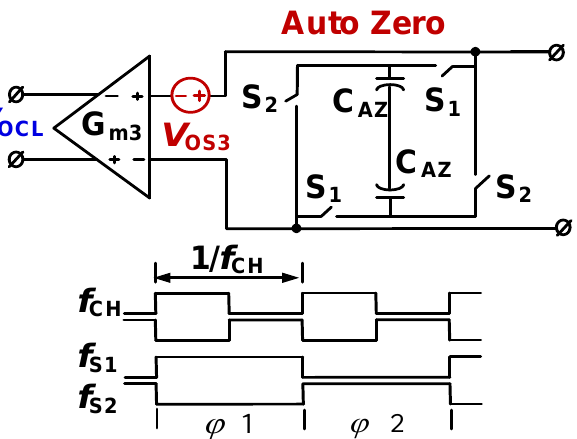
Figure 4. Schematic of the auto-zero offset A-G m3 and timing diagram.